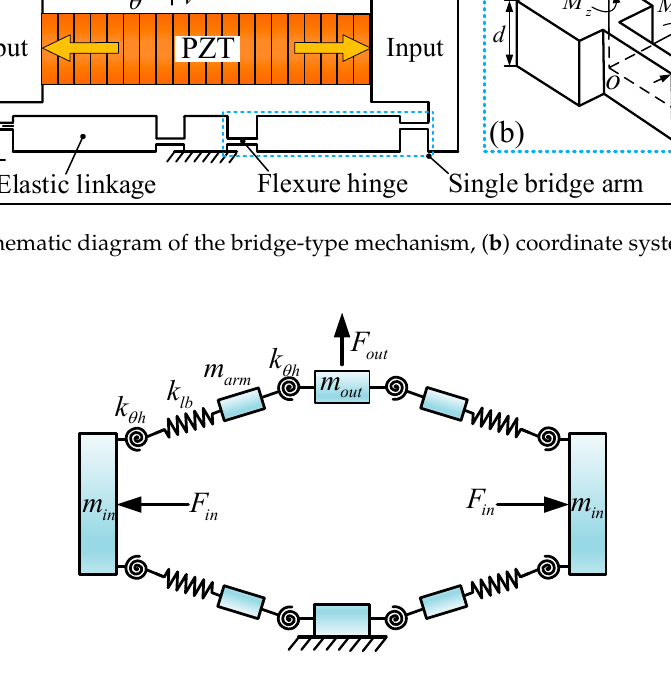
Figure 5. Simplified model of the bridge ‐ type mechanism.